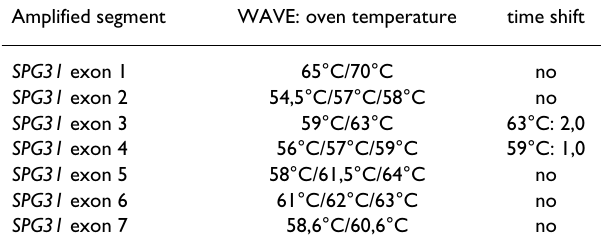
Table 2: WAVE conditions Amplified segment WAVE: oven temperature